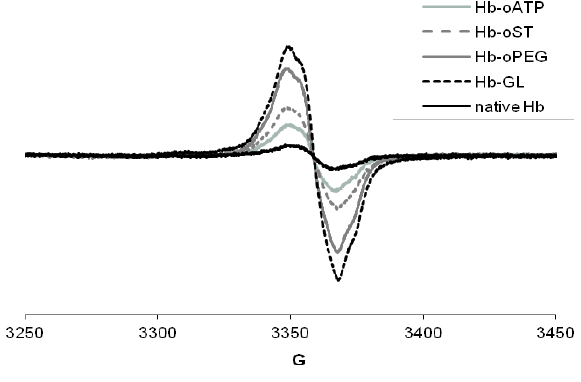
Figure 3. EPR spectra of globins treated with H hydrogen peroxide, PBS, frozen at 30 s after mixing. Hb-oATP: Hb derivatized with periodate-oxidized ATP; Hb-oST: Hb derivatized with periodate-oxidized starch; Hb-oPEG: Hb derivatized with oxidized PEG; Hb-GL: glutaraldehyde-polymerized